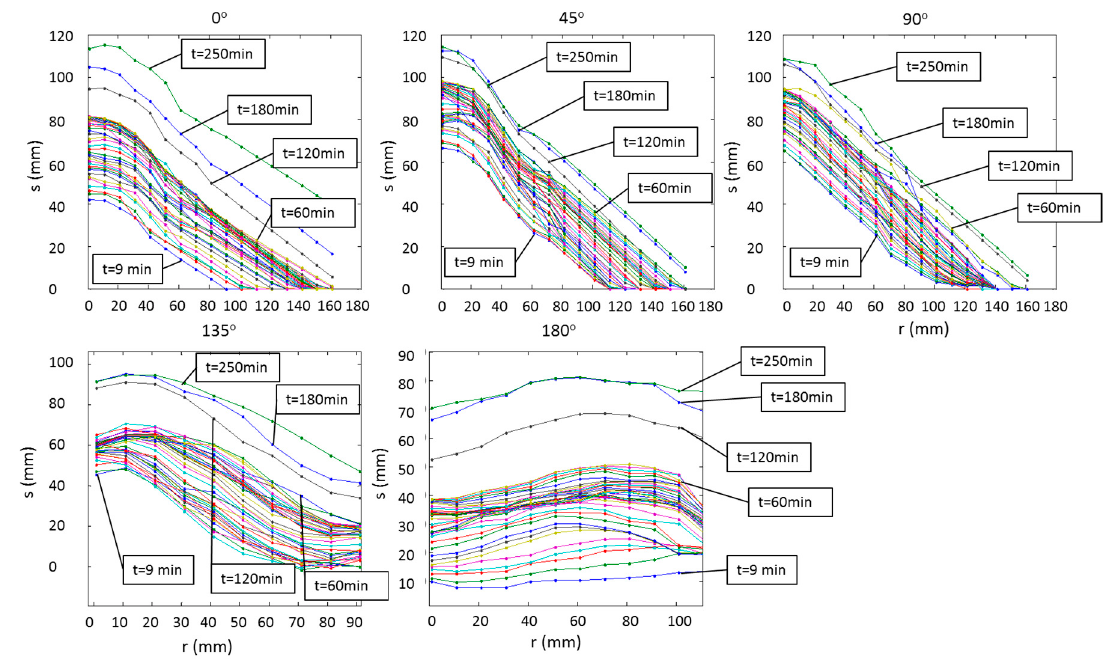
Figure 9. Scour depth against radial distance from the surface of the cylinder, for various instants after t = 9 min, in 5 angular planes, around the cylinder.